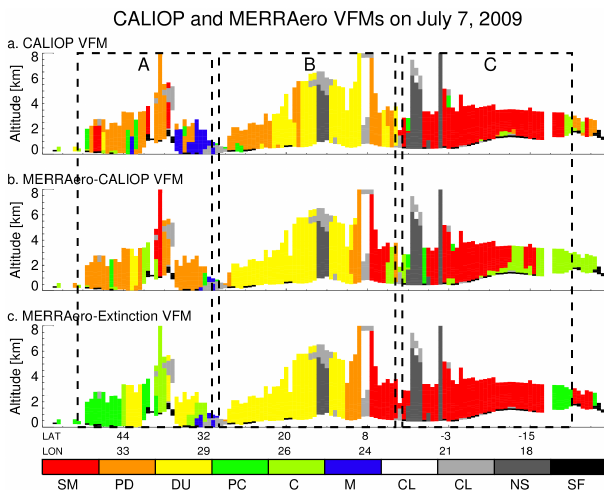
Figure 6. (a) CALIOP VFM, (b) MERRAero-CALIOP VFM, and (c) MERRAero-Extinction on 7 July 2009. Aerosol types include smoke (SM), polluted dust (PD), desert dust (DU), clean continen- tal (C), and marine (M). Regions free of aerosol and clouds are clas- sified as clear. Clouds (CL) and associated signal attenuation (NS), as well as the surface (SF), are also